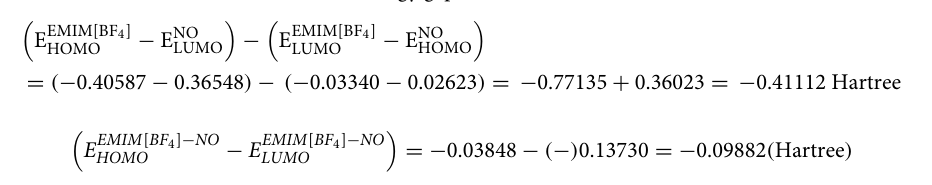
Table 1. Calculated HOMO–LUMO energy of the RTIL, NO and RTIL–NO.